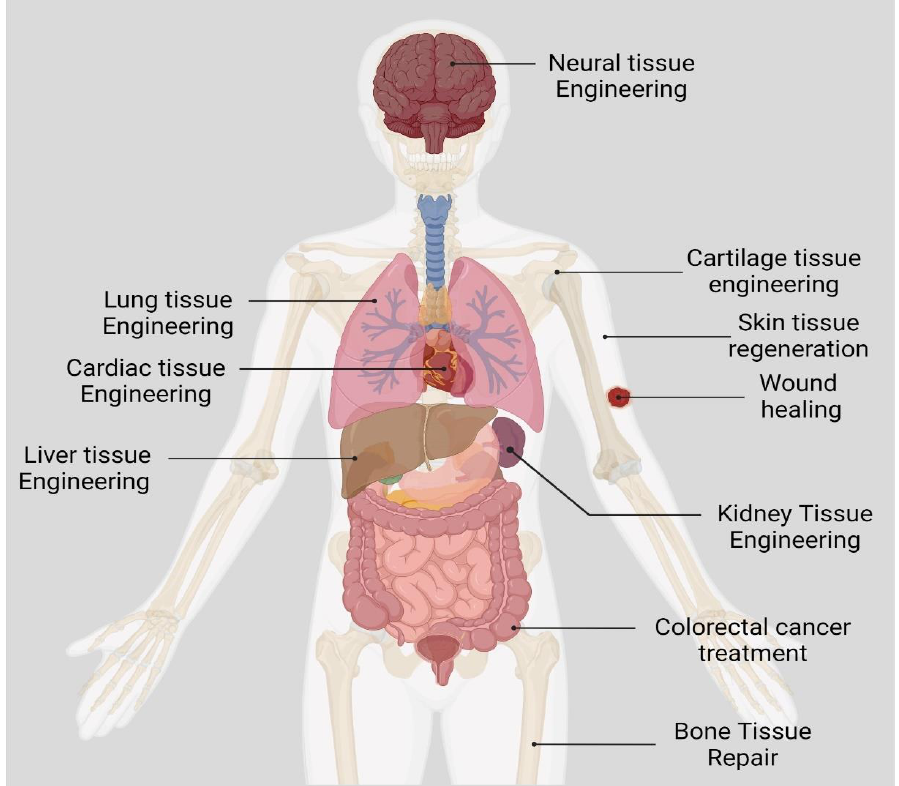
Figure 5. Biomedical applications of Electrospun nanofibers. Created with BioRender.com (accessed on 11 September 2022).